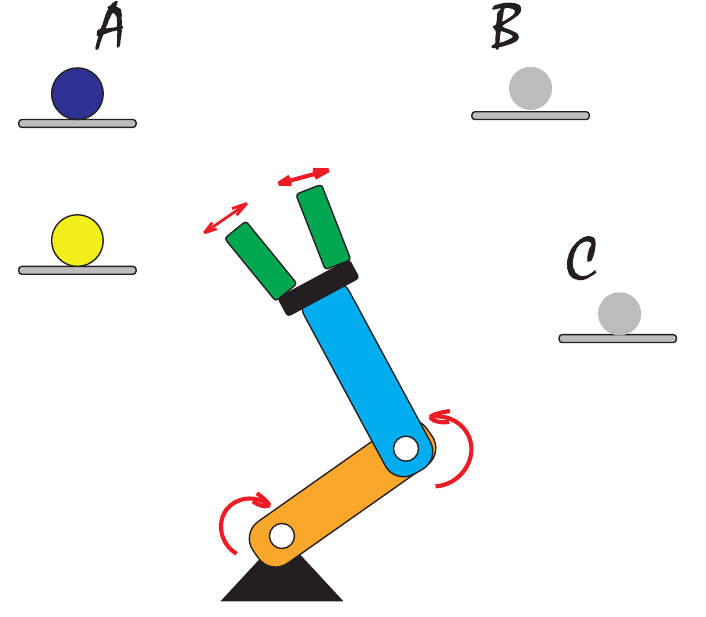
Figure 1. Scheme of the